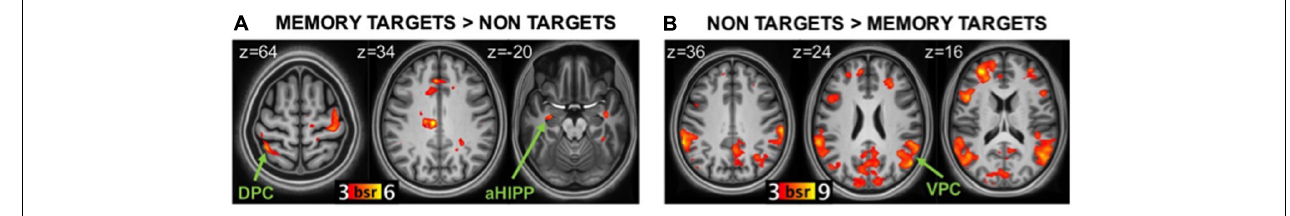
FIGURE 3 | Brain regions related to memory targetness. (A) regions more active during detection of memory targets (hits in the Incentive-old condition and CRs in the Incentive-new condition) than non-targets (CRs in the Incentive-old and hits in the Incentive-new condition). (B) regions more active during detection of non-targets than memory targets. DPC, dorsal parietal cortex; VPC, ventral parietal cortex; aHIPP, anterior hippocampus; BSR, salience/standard error ratio from the bootstrap analysis.